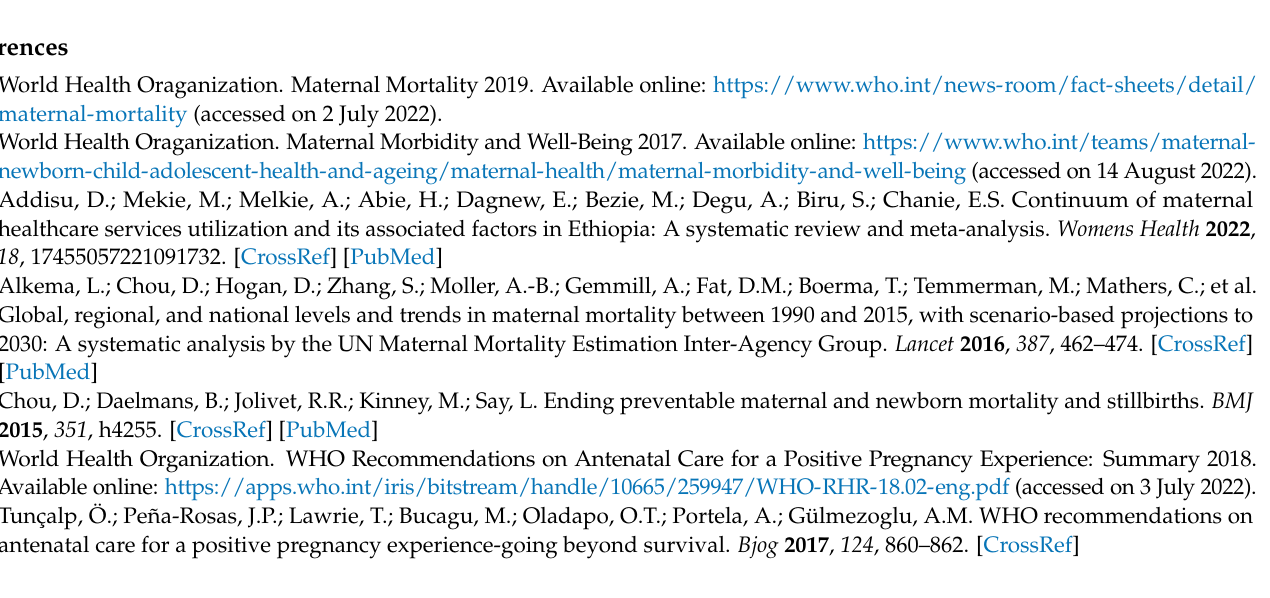
Figure S4: Forest plot of the association between various dimensions of women’s agency and more than four ANC visits; Figure S5: Forest plot of the association between various dimensions of women’s agency and more than eight ANC visits; Figure S6: Forest plot of the association between various dimensions of women’s agency and facility-based delivery; Figure S7: Forest plot of the association between various dimensions of women’s agency and using skilled birth attendants; Figure S8: Forest plot of the association between various dimensions of women’s agency and using skilled birth attendants; File S1, Table S1: MMAT quality appraisal